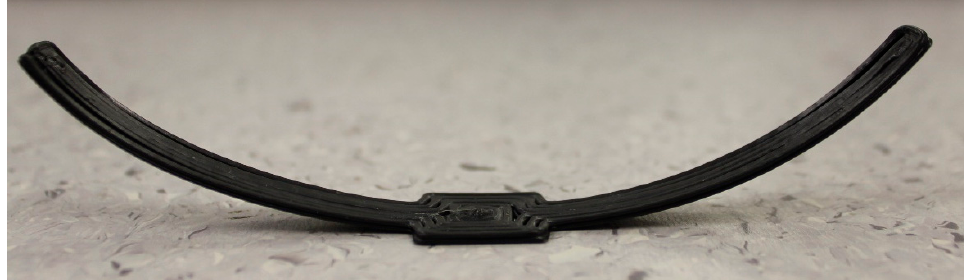
Figure 5. 3D printed polypropylene (PP) shrinkage test sample. Created by Kim Pickering and David Stoof.